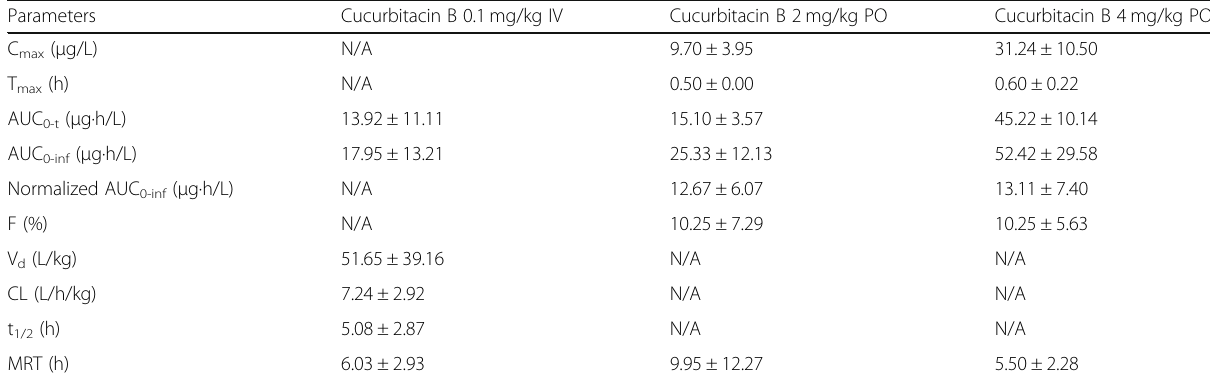
Table 6 Pharmacokinetic parameters of cucurbitacin B